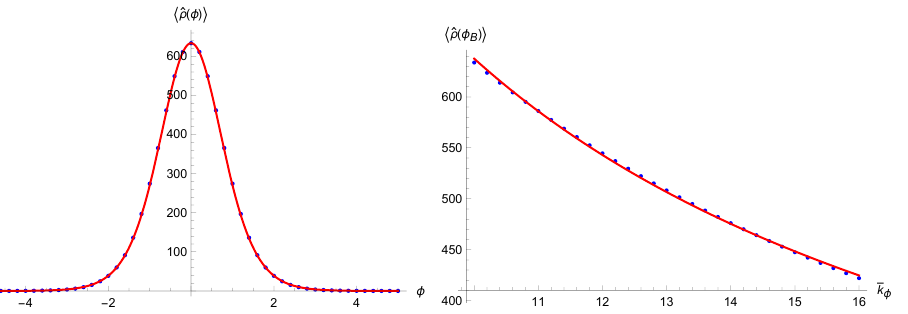
Figure 4. ( Left ): the expectation value of the energy density as function of time for k φ = 10 (blue dots); ( right ): the expectation value of the energy density at the time φ B of the Bounce as function of k φ (blue dots). Both have been fitted with a function in accordance with the semiclassical evolution (full red